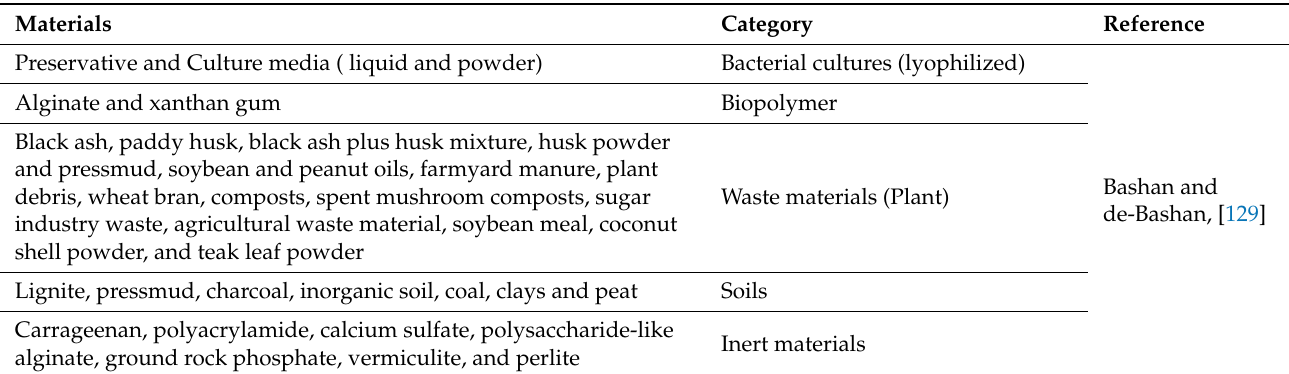
Table 5. Microbial inoculants carrier types as